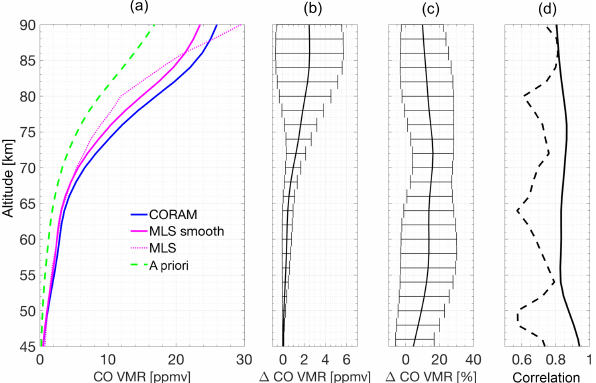
Figure 6. (a) The mean of the daily CORAM and MLS CO pro- files above Ny-Ålesund. The mean of the unsmoothed MLS profiles is also shown, as well as the a priori profile used for the CORAM inversions. (b) The absolute difference of the mean CORAM and smoothed MLS profiles, with the standard deviation of the differ- ences as the whiskers on the line. (c) The same as for (b) but with the difference as a percentage of the mean CORAM and MLS pro- files. (d) The correlation coefficients of the CORAM and smoothed MLS data (solid line) or unsmoothed MLS data (dashed